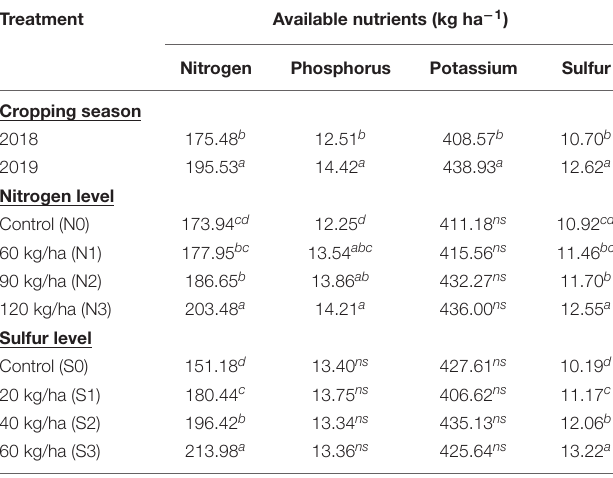
TABLE 7 | Effect of year and fertilization levels on soil available nutrients. Treatment Available nutrients (kg ha − 1